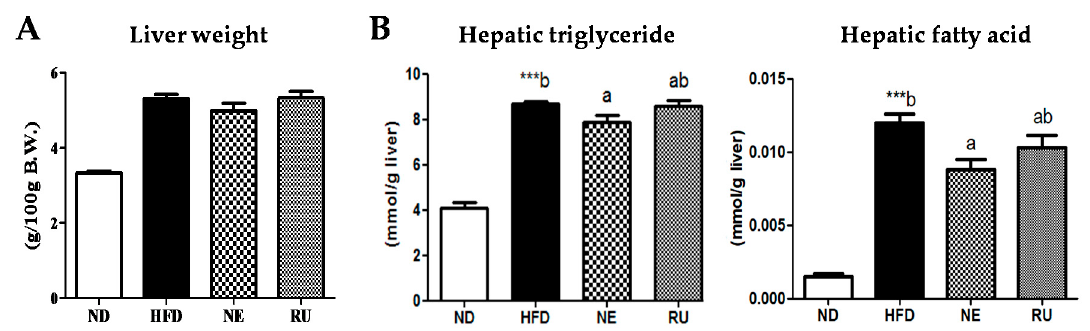
Table 2. Effect of NE and RU supplementation for 16 weeks on plasma lipid profiles in C57BL/6J mice fed high-fat